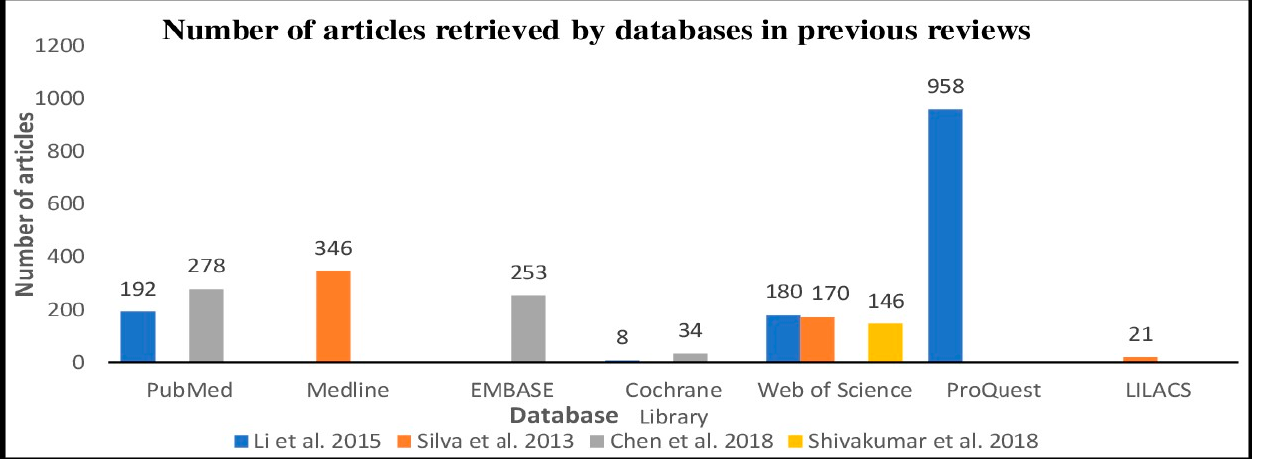
Figure 4. Number of articles retrieved by each database in previous reviews.